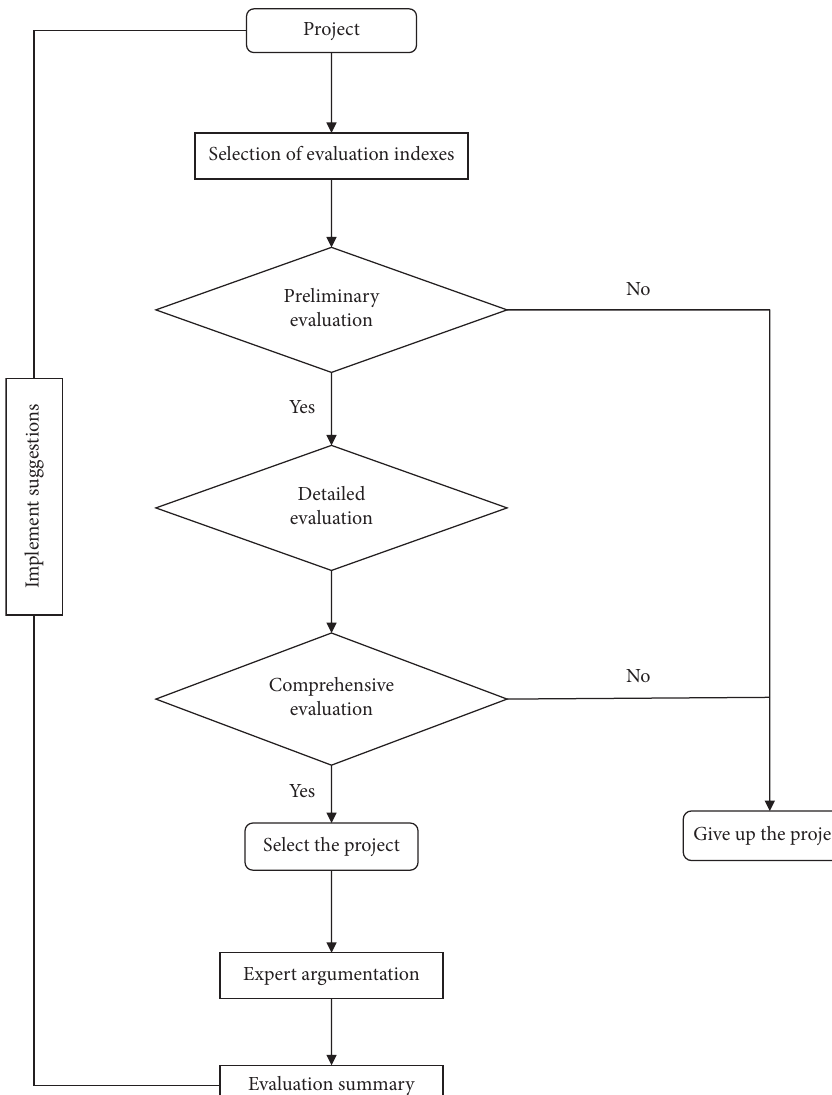
Figure 2: Flowchart of pre-evaluation of industrialization of sci-tech